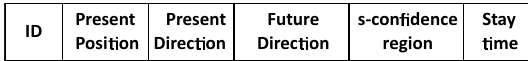
Figure 1. Protocol operation of position-aware mobility pattern (PAMP).